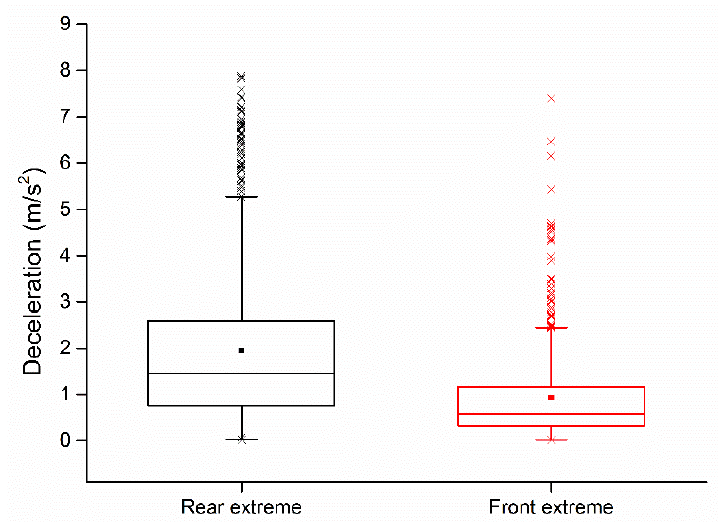
Figure 10. Minimum Safe Deceleration (MSD) for the extreme moment .